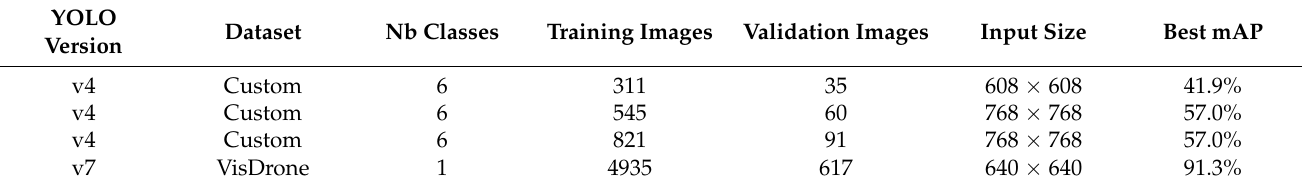
Table 4. Hyperparameters and results of the training of the YOLOv4 object detector for several